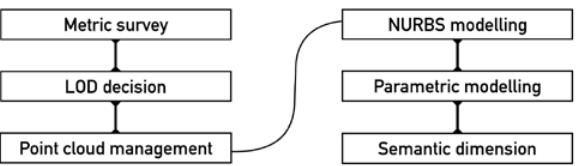
Figure 1. Schema of HBIM creation starting from metric information and NURBS